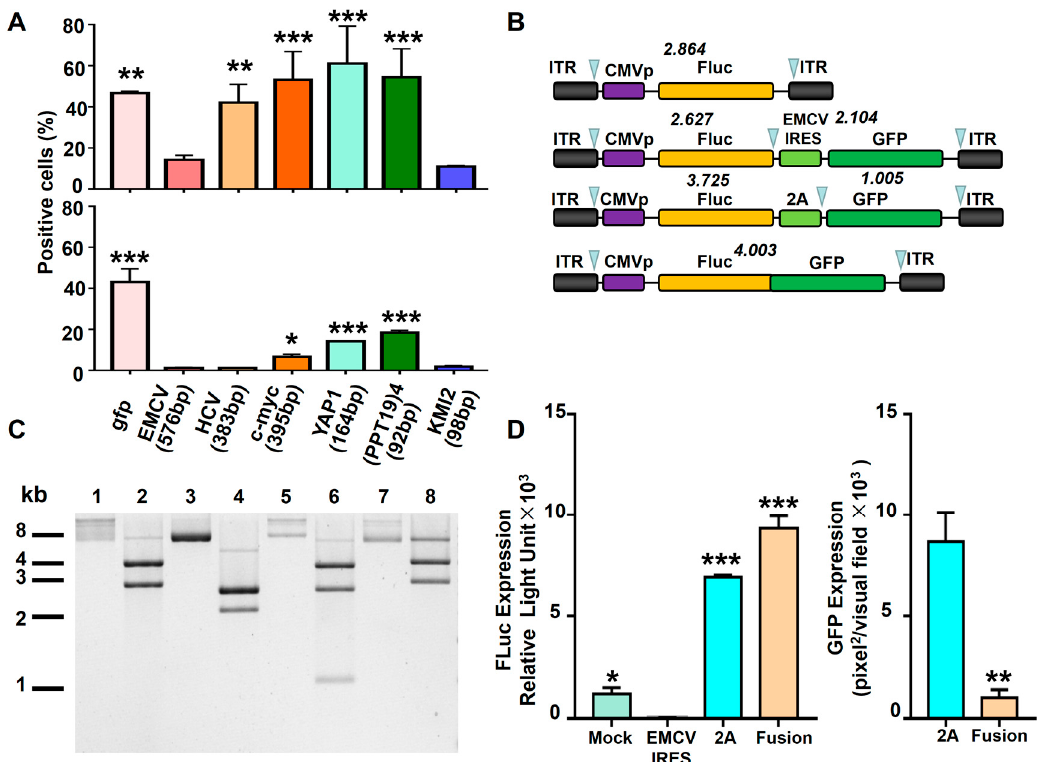
Figure 6. The transgene expression from various bicistronic rAAV6 vectors in hematopoietic cells. ( A ) HEK293 (upper) and K562 (lower) cells were transduced with rAAV6-CMVp-IRES- gfp at 10,000 vgs / cell. The six di ff erent IRES elements are described in the manuscript. Transgene expression was detected by flow cytometry at 72 hours post-transduction. ( B ) Diagram of the rAAV6 vector genomes. ( C ) Enzyme digestion of plasmids in (B). Lines 1, 3, 5, and 7 were undigested plasmids. Lines 2, 4, 6, and 8 were plasmids digested by SmaI. SmaI-pAAV-CMVp- fluc (11, 11, 2864, 4095bp); SmaI-pAAV-CMVp- fluc -EMCV IRES- gfp (11, 11, 2104, 2627, 2681bp); SmaI-pAAV-CMVp- fluc -2A- gfp (11, 11, 1005, 2651, 3725bp); SmaI-pAAV-CMVp- fluc - gfp (11, 11, 3007, 4003bp). ( D ) The expression of Fluc and GFP from (B) was detected at 72 hours post-transduction.